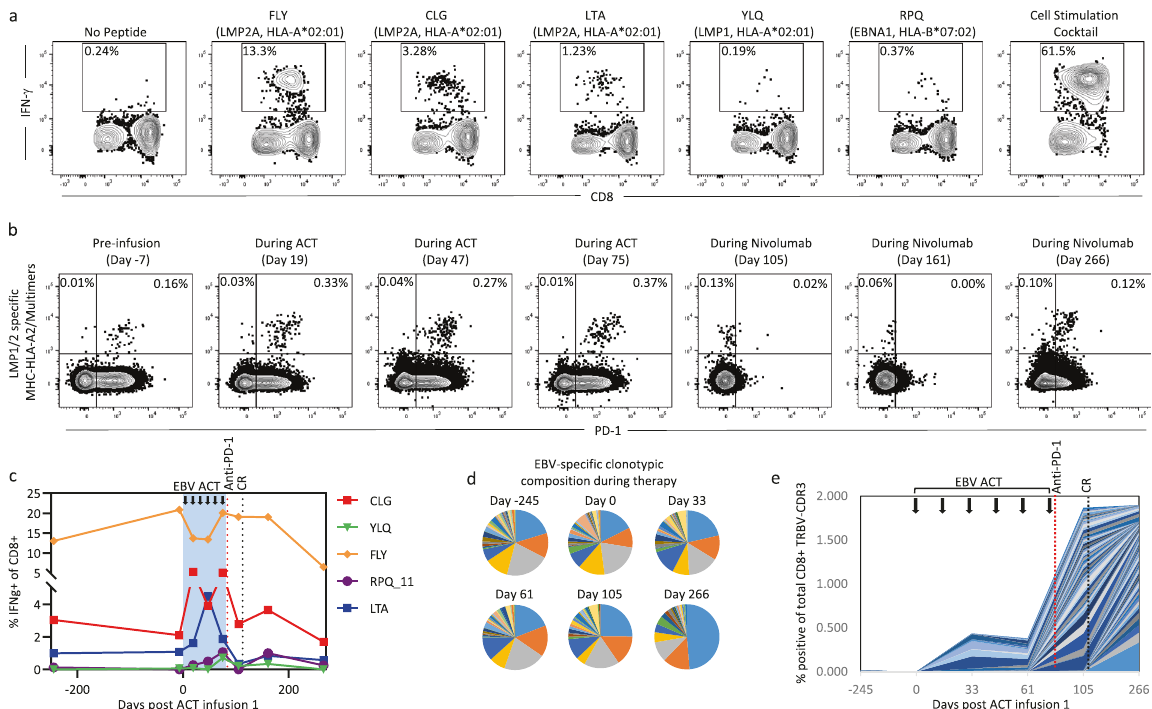
Fig. 2 EBV-speci fi c immunological monitoring following immunotherapy. a The speci fi city of T cells generated for cellular therapy was assessed using a standard intracellular cytokine assay following recall with HLA-matched peptide epitopes. Flow cytometry plots show the frequency of CD8 + T cells speci fi c for six different EBV-encoded peptides or a positive control cell stimulation cocktail (eBioscience). b PBMC isolated during the course of treatment were assessed for PD-1 expression and the presence of EBV-speci fi c T cells using a pool of HLA- A*02:01-restricted MHC dextramers. Plots show the proportion of MHC multimer-speci fi c CD8 + T cells that co-express PD-1. c PBMC isolated during the course of treatment were stimulated for 2 weeks using an adenoviral vector encoding EBNA1 and multiple CD8 + T cell epitopes from LMP1 and LMP2 (AdE1-LMPpoly), then recalled with HLA-matched peptides. Data represent the proportion of IFN- γ producing CD8 + T cells in response to each peptide. d TRBV-CDR3 deep sequencing analysis was performed on two sets of samples: 1. CD8 + T cells sorted from PBMC isolated during the course of treatment, and 2. MHC multimer + CD8 + T cells sorted from the ACT product. Pie charts show the proportions of MHC multimer + EBV-speci fi c TRBV sequences from the ACT product that were also detected in the PBMC during the course of treatment. Each wedge represents an individual clonotype and identical clonotypes in each pie chart are represented by the same color. Only clonotypes that were present in the MHC multimer + population from the ACT product are included. e The chart shows the frequency of novel clonotypes in the total CD8 + T cell population that signi fi cantly expanded after the commencement of ACT. Each color represents an individual clonotype. Only clonotypes that signi fi cantly expanded after the commencement of ACT are